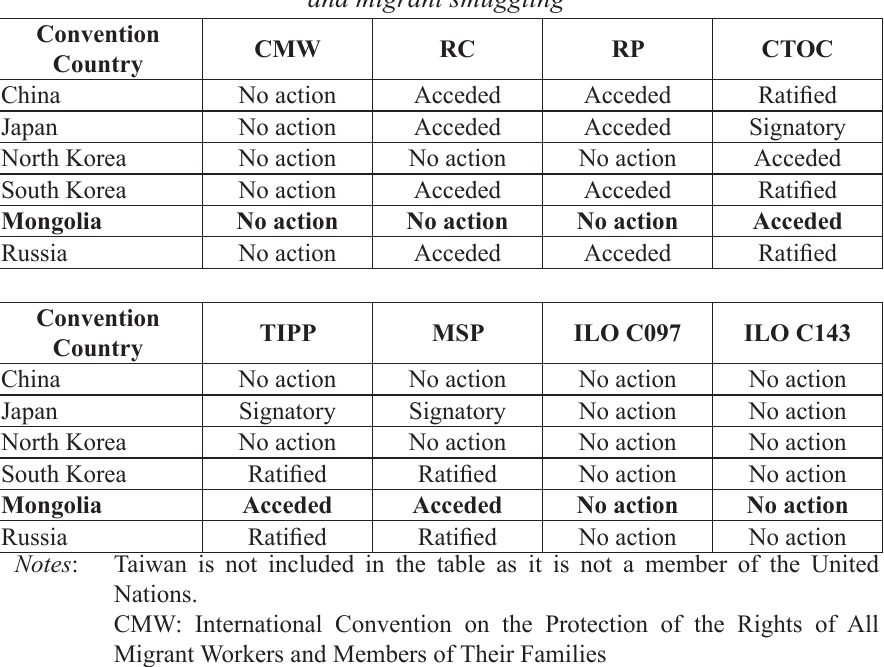
Table 4. Status of ratifications by Northeast Asian countries of principal international conventions concerning migrants, refugees, and human trafficking and migrant